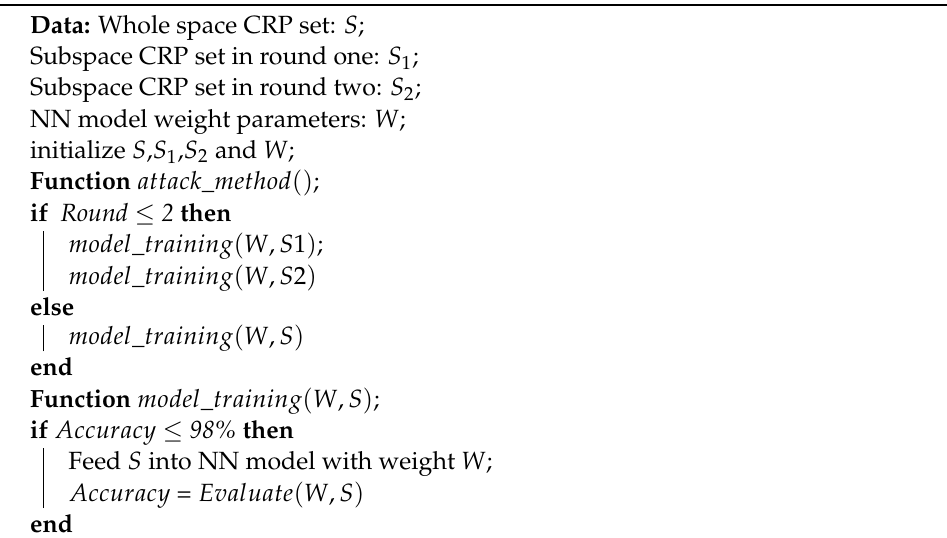
Algorithm 1: Subspace pre-learning attack method.